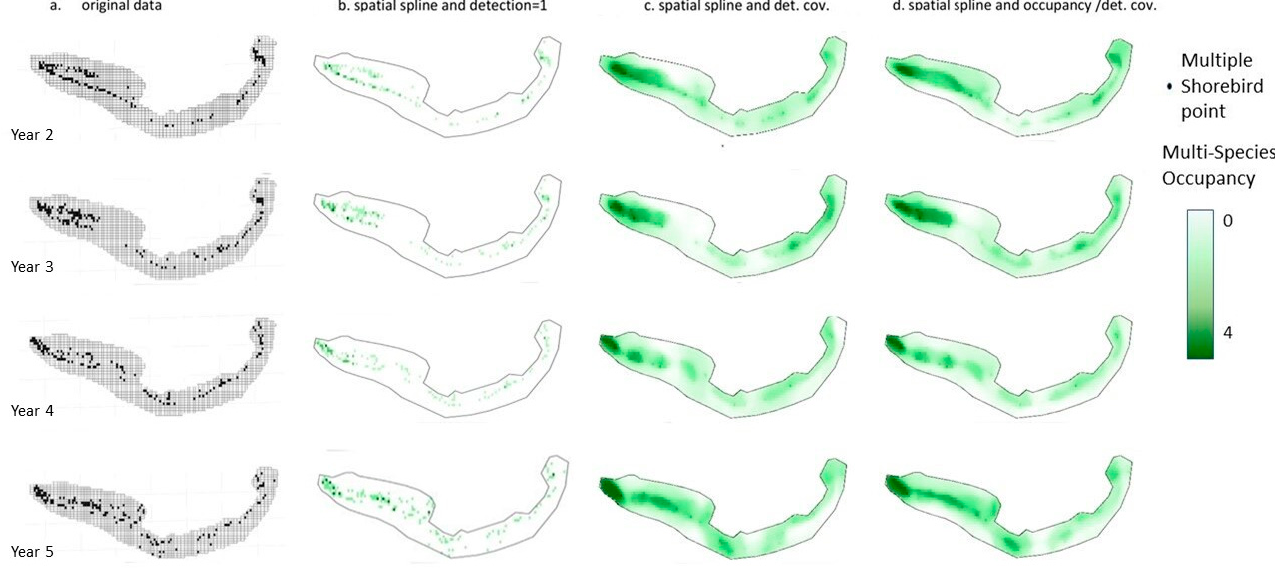
Figure 3. Species richness maps with the spatial spline for the island’s four other migratory bird species (Wilson’s plover, American oystercatcher, snowy plover, and red knot). Values range from 0 (white) to 4 (dark green). Table 3. Piping plover model estimates for occupancy, reporting the mean and 97.5% con fi dence interval (CI) for each of the four models across the fi ve years.